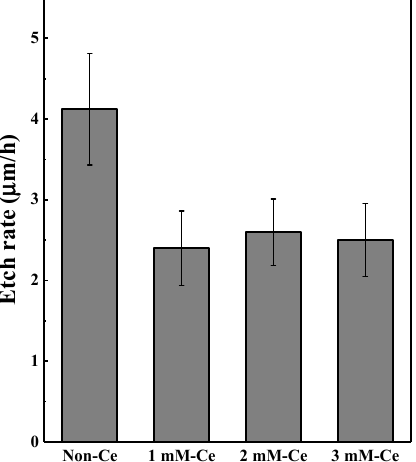
Figure 7. Etching rate of AAO film after CF 4 / Ar / O 2 plasma exposure for 1 h.